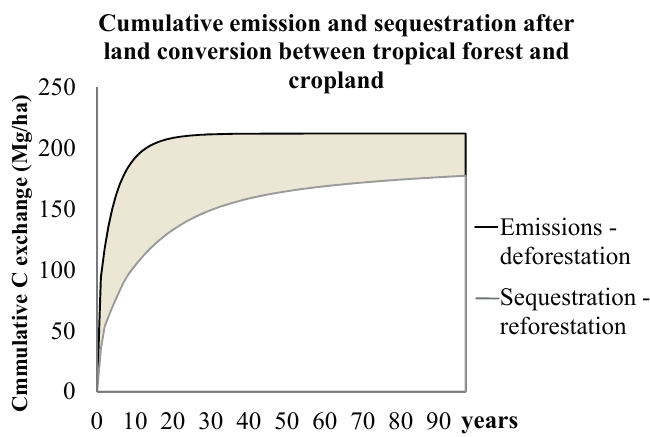
Figure 3. The differences between emissions from deforestation and sequestration from reforestation in years after a land use change event. The grey area shows the net emissions resulting from relocation of a unit of cropland within tropical